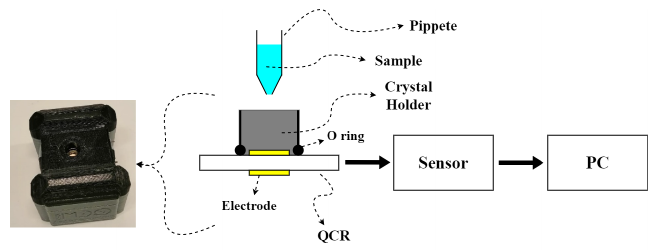
Figure 1. Experimental set-up.